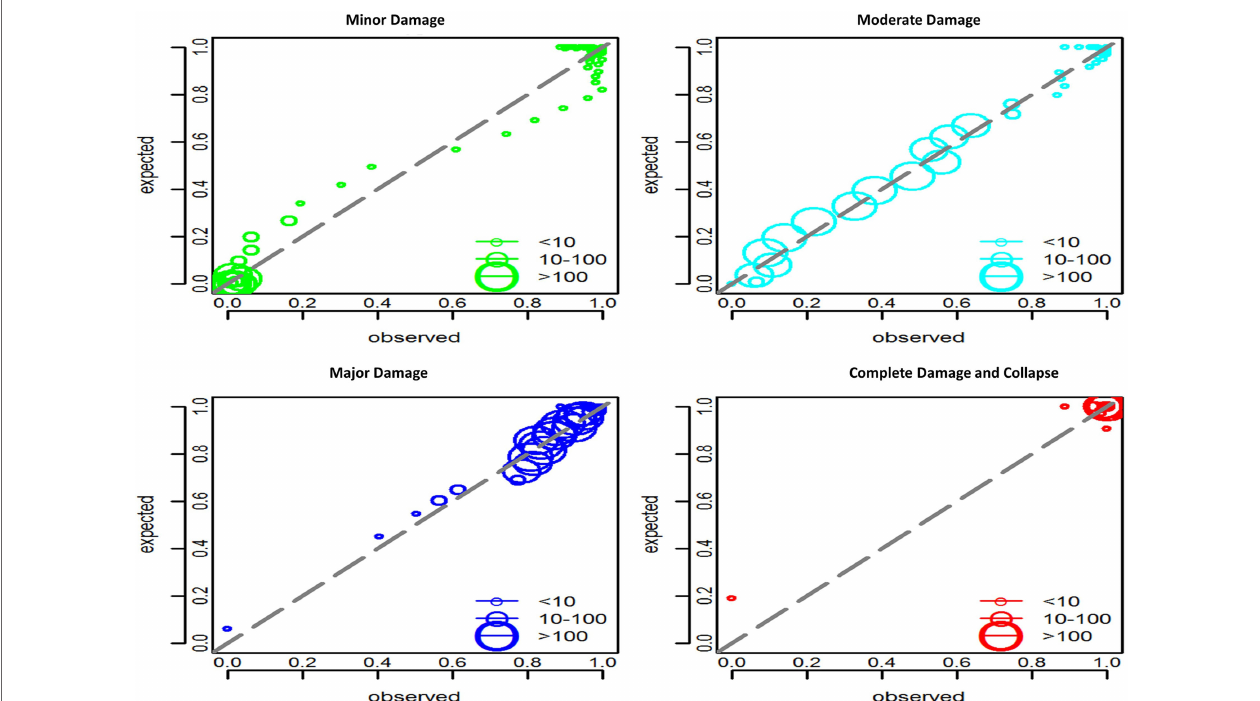
FIGURE 5 | Expected versus observed probabilities after fitting a multinomial model to the building damage data used in Charvet et al. (2014b), for 1 storey timber buildings. The green, light blue, dark blue, and red color codes correspond respectively to DS1, DS2, DS3, DS4 and over, as per damage descriptions in Table 6 . A good fit is indicated by counts following closely the 45